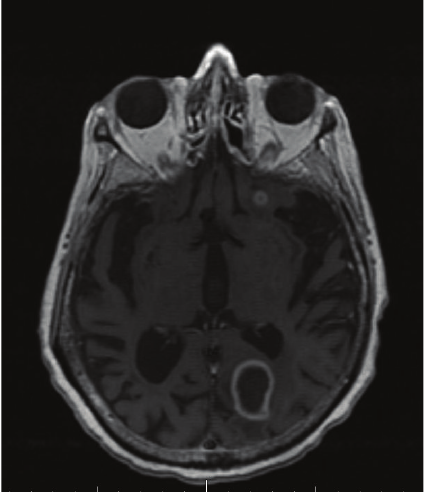
Figure 4: Magnetic resonance imaging of the brain showing ring enhancing lesion in the left parietal lobe, one month after initial